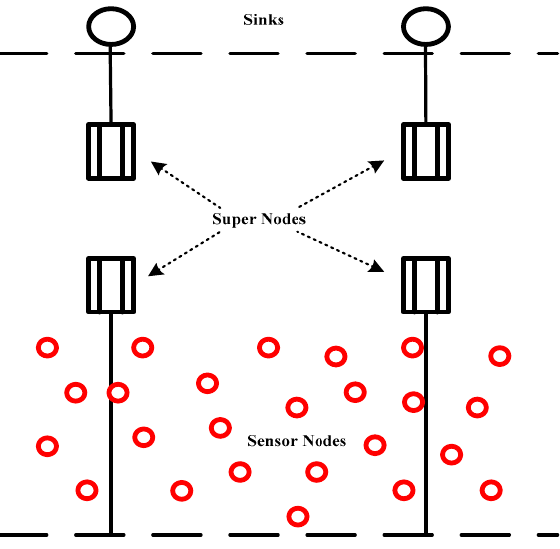
Figure 12. The use of super nodes in MRP.